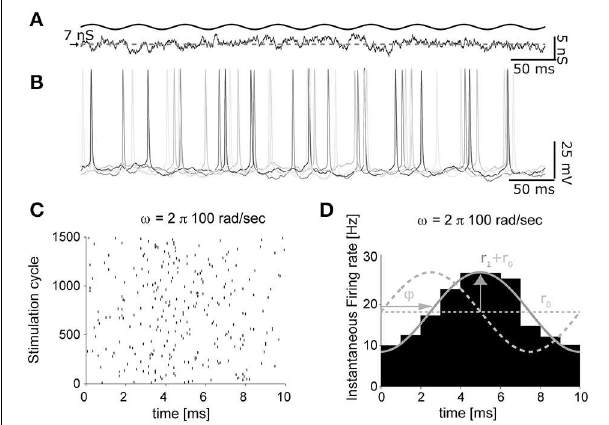
FIGURE 5 | The impact of artificial background synaptic conductances (non-stationary) injection. The protocol of Figure 4 , was adapted to feature time-varying presynaptic firing rates (A) , oscillating sinusoidally in time. The instantaneous firing response, evoked by an input oscillation of 100 cycles/s (B) , was then processed to extract the times of each spike, across several repeated trials (i.e., cycles of the background synaptic conductance oscillation), and represented as a raster diagram (C) . Once the spike times histogram is evaluated (D) , the linear dynamical response of the neuron can be quantified as the average r 0 and the peak firing rates r 1 , as well as the phase ϕ with respect to the input